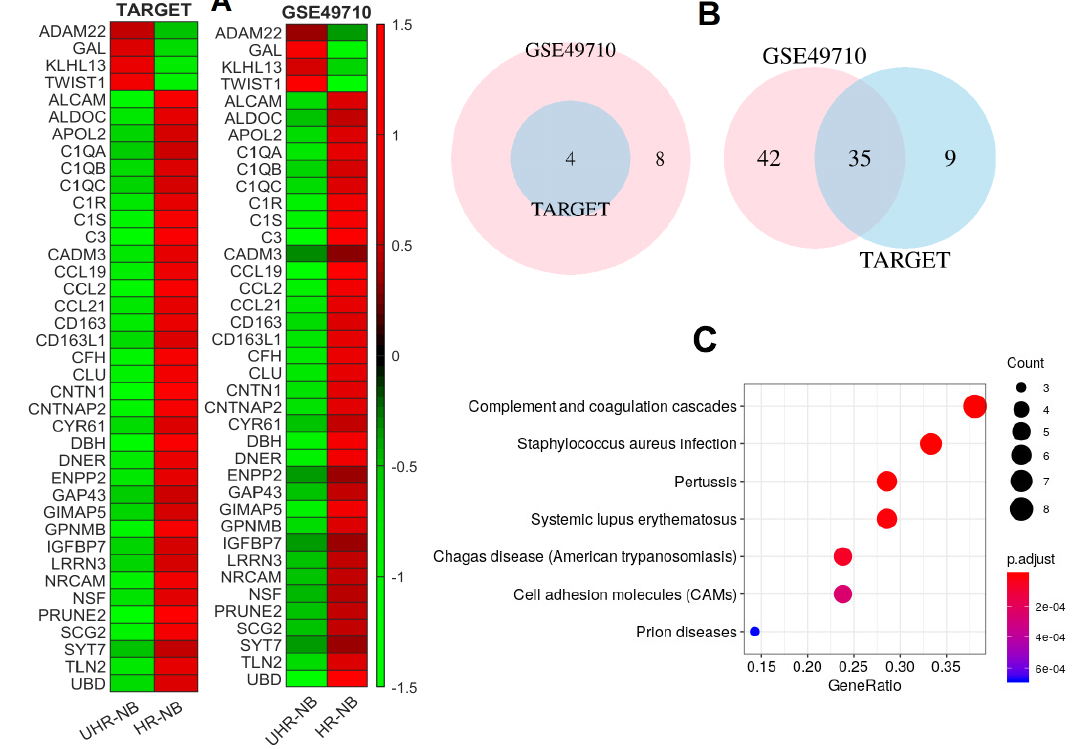
Figure 2. The 39 commonly differentiated NB-specific immune genes and their biological characterization. ( A ) Heatmaps of the 39 commonly differentiated immune-related genes in both cohorts. ( B ), Venn diagram depicting the number of commonly differentiated NB-specific immune-related genes, where the left and right diagrams were for the up- and down-regulated genes, respectively, and ( C ), enriched KEGG pathways for 35 commonly down-expressed NB-specific immune-related genes in ultra-high risk neuroblastoma